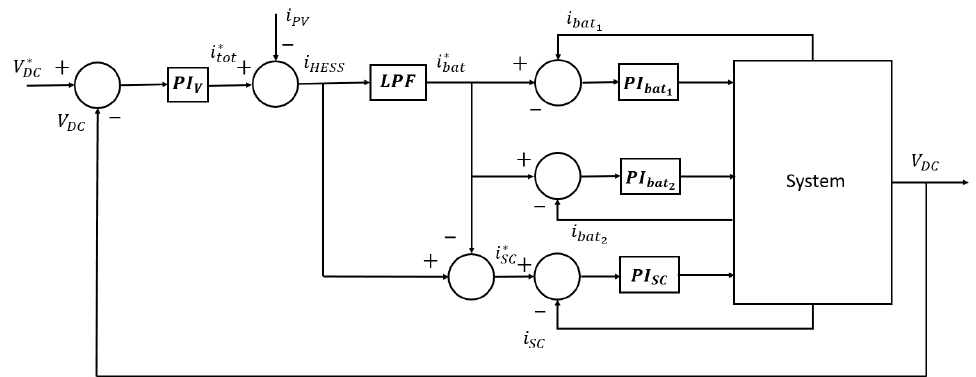
Figure 4. Conventional FBM